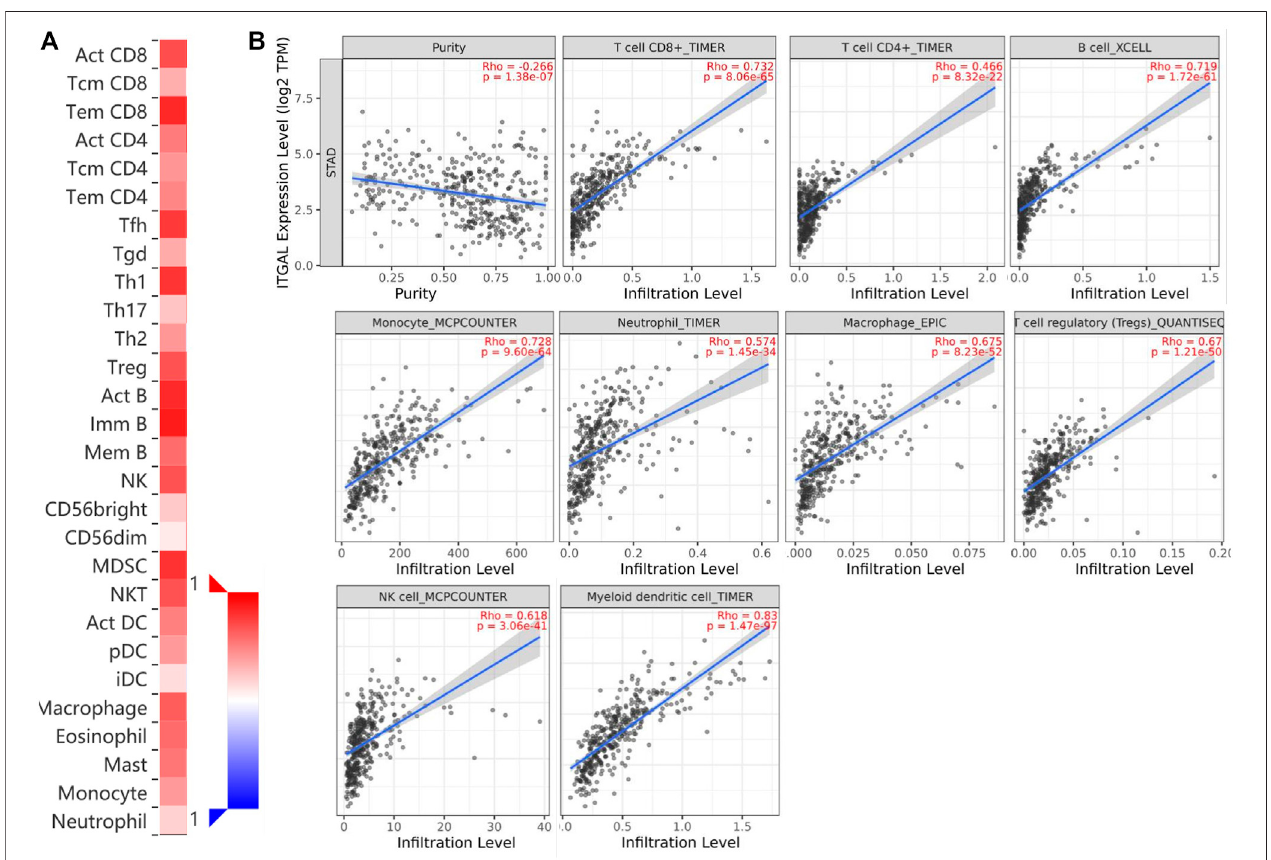
FIGURE4| CorrelationofITGAL expression withimmune in fi ltration in gastric cancer. (A) Correlationbetweenthe expression ofITGAL and theabundance ofTILs in gastric cancer available at TISIDB database. (B) Correlation of ITGAL expression with in fi ltration levels of CD8 + T cell, CD4 + T cell, Treg cell, B cell, neutrophil, macrophage, myeloid dendritic cell, natural killer cell, and monocyte in gastric cancer available at TIMER2.0 database. TILs, tumor-in fi ltrating lymphocytes; TIMER2.0, Tumor Immune Estimation Resource. Color images are available online.